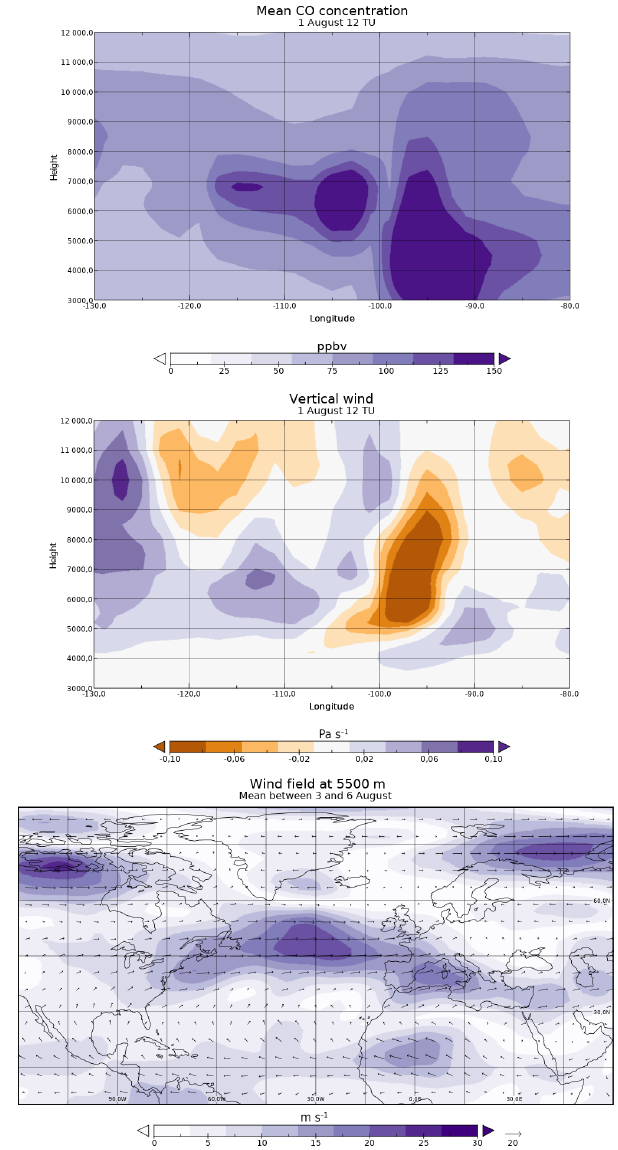
Figure 8. (a) Longitude-altitude cross section of the mean CO con- centrations from MOCAGE on 1 August, 12:00UTC, between 40 and 70 ◦ N. (b) Vertical wind between 40 and 70 ◦ N (box repre- sented by the green square on Fig. 7a) on 1 August 12:00UTC. (c) Mean wind field at 5.5kma.s.l. between 3 and 6